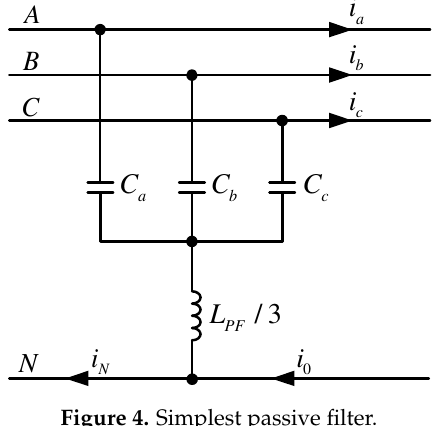
Figure 4. Simplest passive filter.